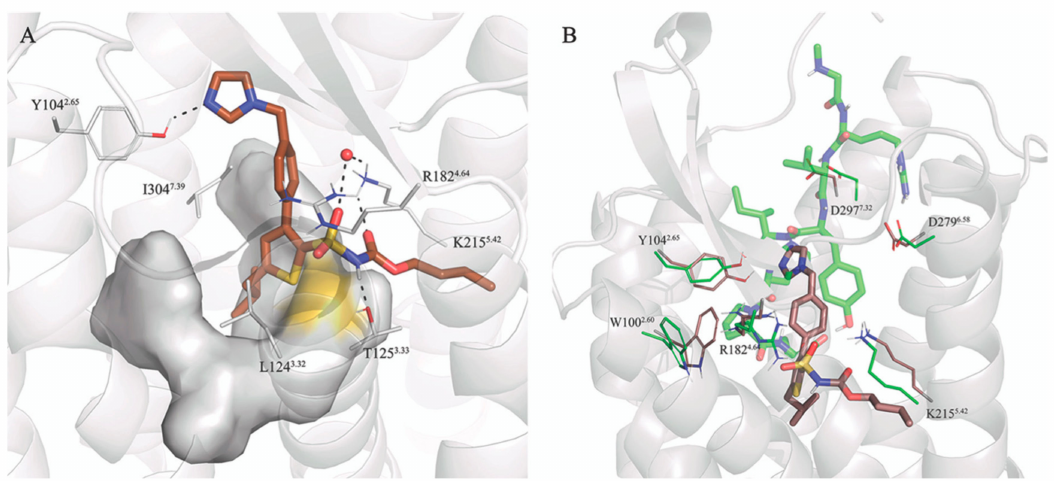
Figure 6. ( A ) Binding mode of C21 (brown sticks) to the AT2R. The grey surface represents the hydrophobic pocket surrounding the isobutyl group of C21 . ( B ) Comparison of the binding modes of C21 (brown sticks) and sarile ( 1 , green semi-transparent sticks). The main AT2R residues showing interactions with each ligand are shown in lines, and hydrogen bonds indicated with dotted